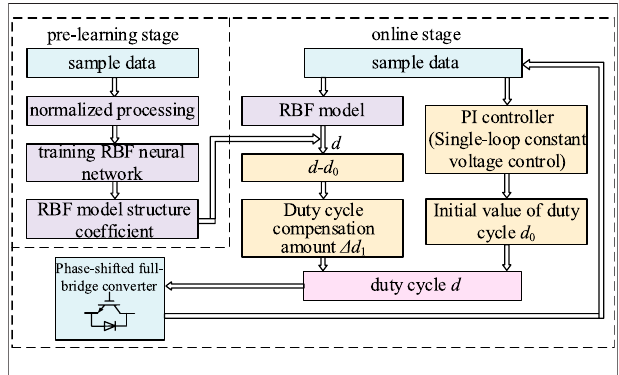
FIGURE 3 | Flowchart of the model design.